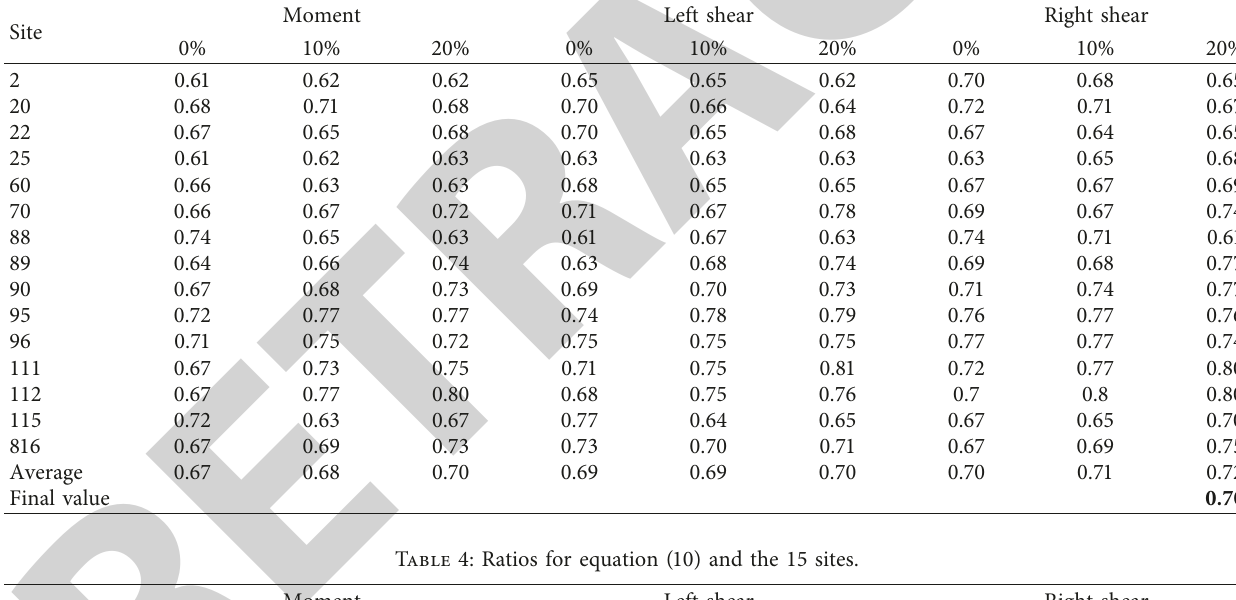
Table 3: Ratios for equation (9) and the 15 sites.